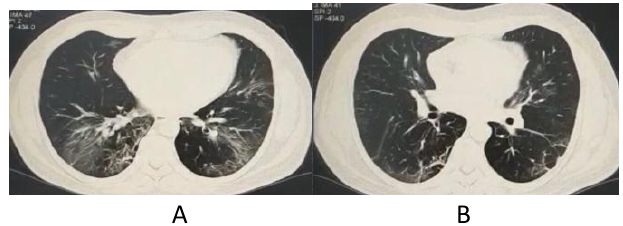
Figure 1 (A & B) : Axial chest CT images of adult patient 3 months after recovery from initial infection with Covid-19, showing fibrous stripes with reticular parenchyma opacification and ground glass appearance seen in the lower lobes of both lungs. Both images have the same window level of − 600 and window width of 1600 The residual radiological findings, patterns, and distribution were summarized in Table 1. Table 1: Residual pulmonary CT findings of patients included in this study